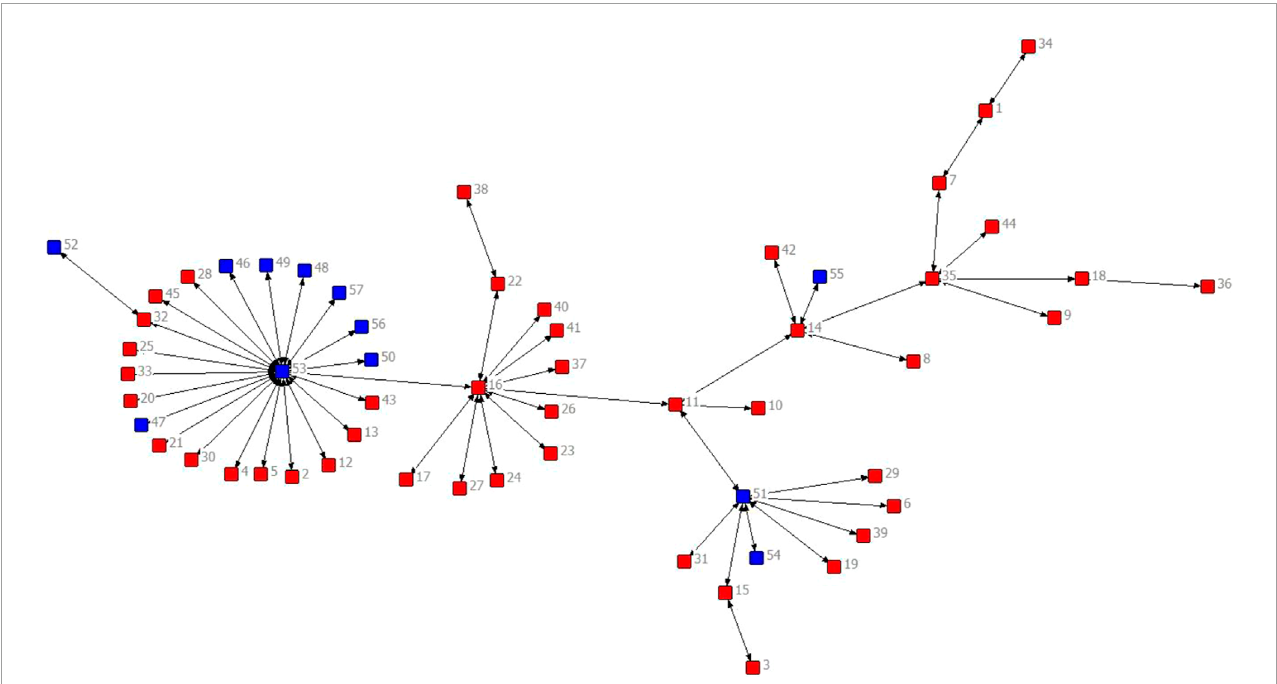
FIGURE 2 Base association tree in the marine industry carbon transfer network in 2020. Note: Nodes 46–57 in the figure represent the marine industry and are shown in blue, while nodes 1–45 represent the rest of the national industry and are shown in red.